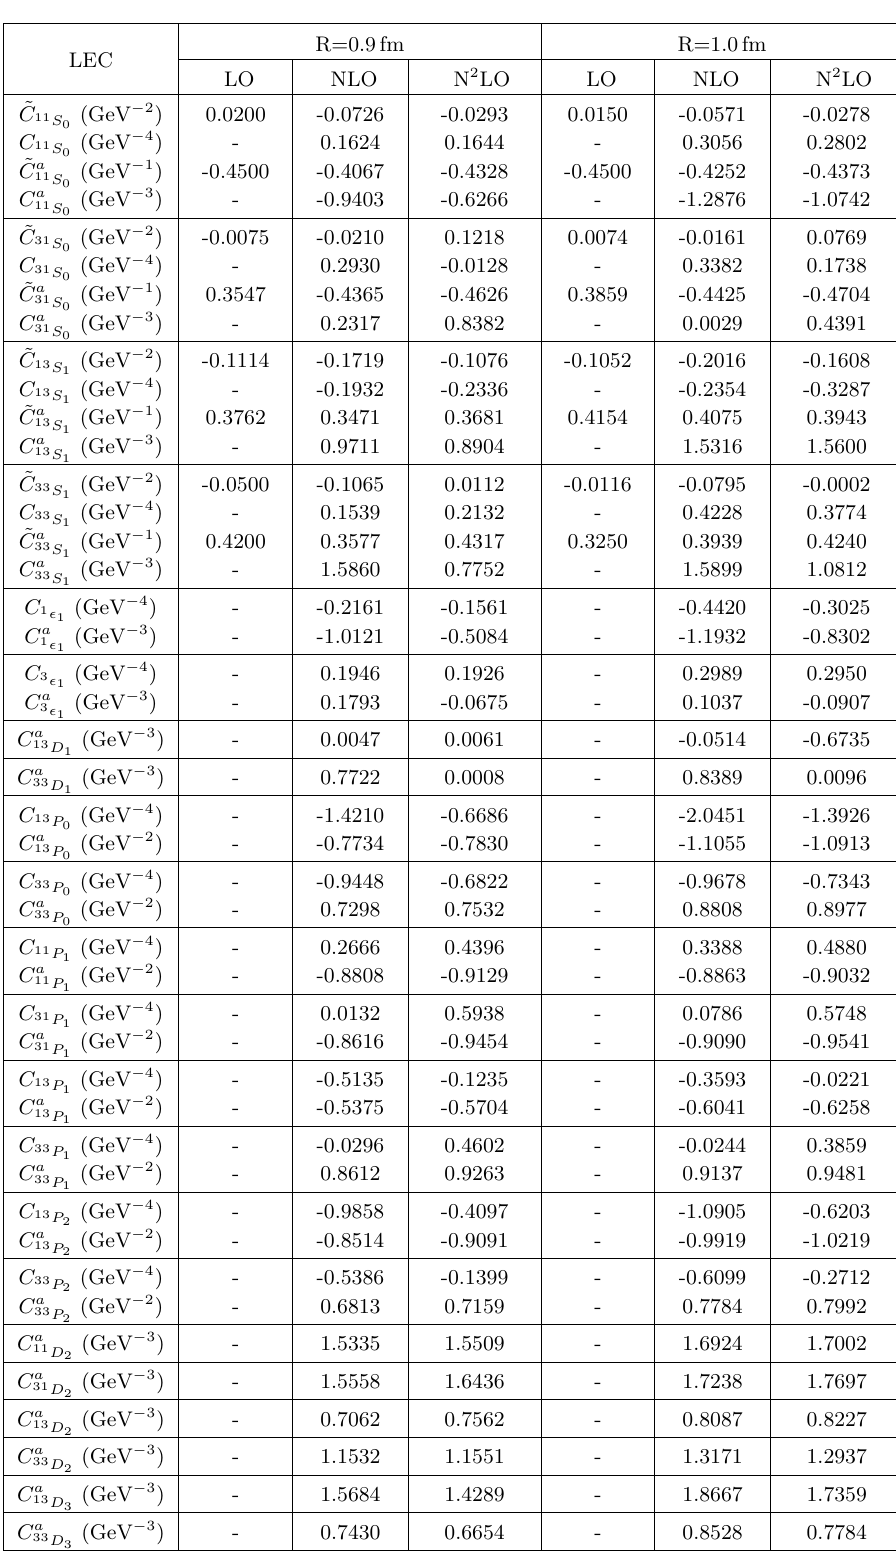
Table 7 . LECs at LO, NLO, and N 2 LO for the cuto(cid:11)s R=0.9 fm and 1.0 fm. The superscript a indicates parameters related to the annihilation part. Note that all parameters are in units of 10 4